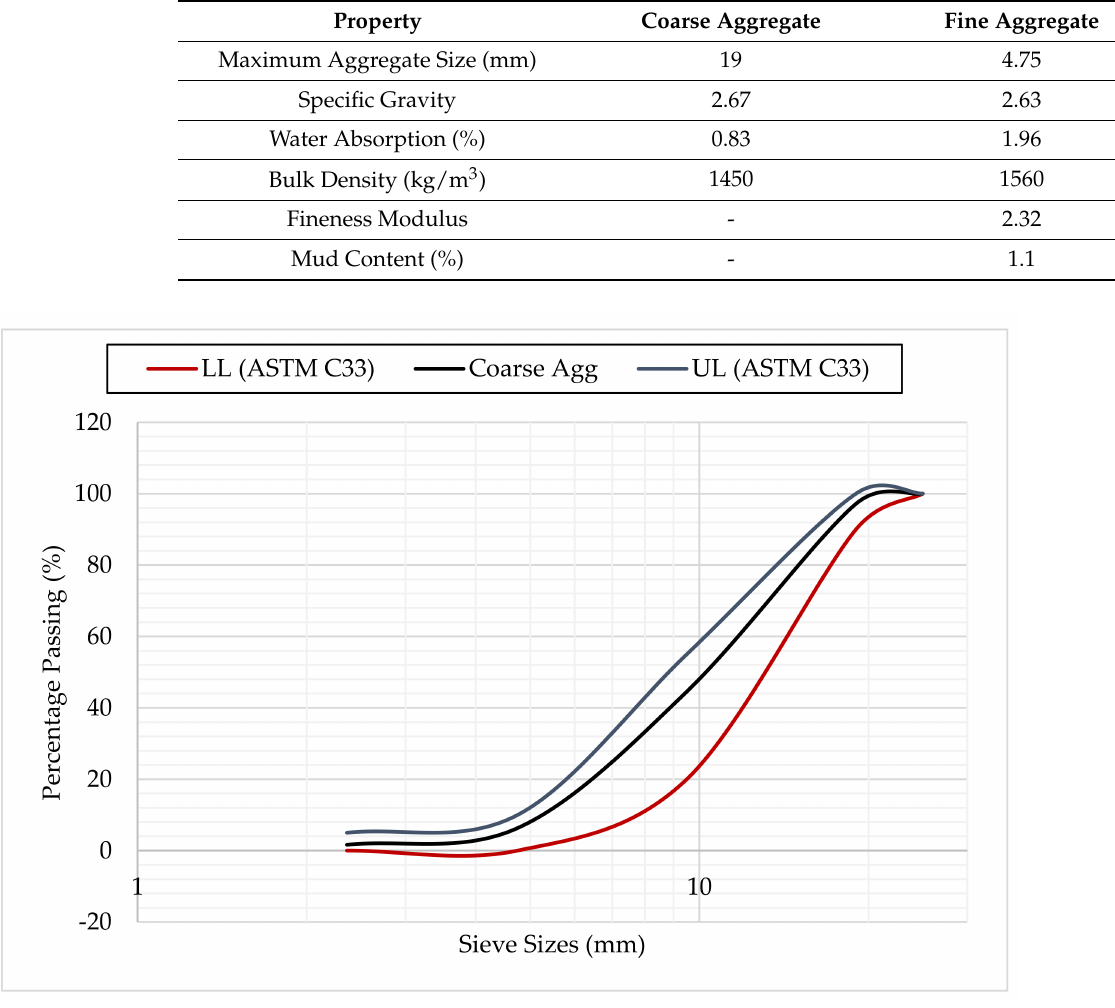
Table 2. Properties of Aggregate.